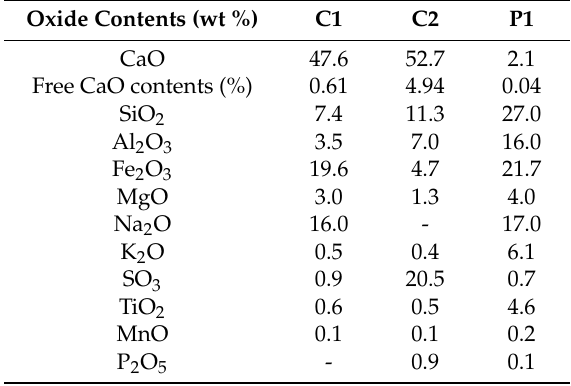
Table 1. Chemical compositions of the circulating fluidized bed combustion (CFBC) bottom ash and PC bottom ash